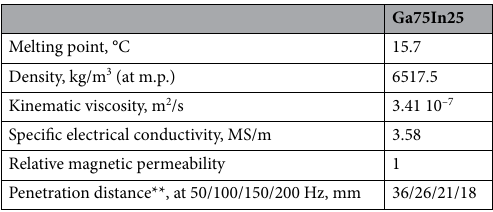
Table 1. Physical parameters of the Ga75wt%In25wt%